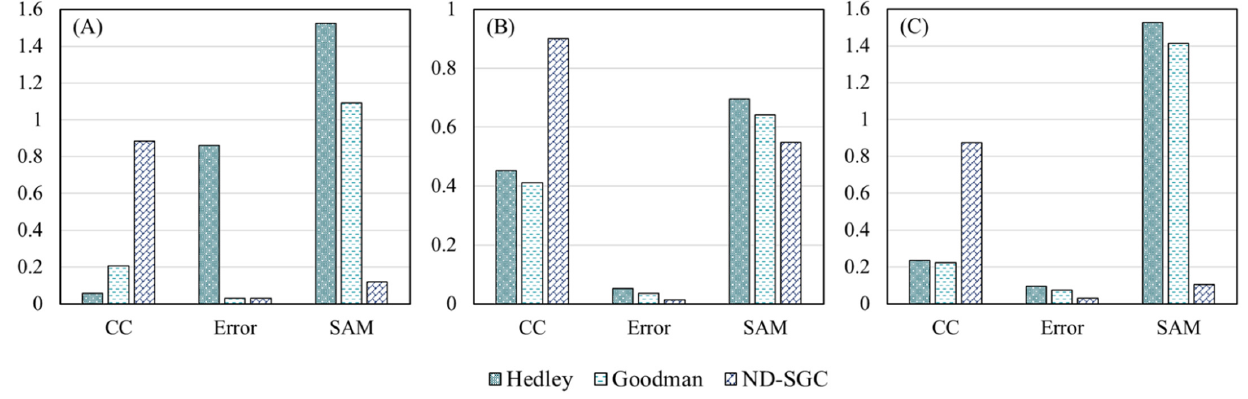
Figure 4. Spectral fidelity evaluation indexes of three sun glint correction methods for three study areas. ( A ) Dongdao Island; ( B ) Tiexian Jiao; ( C ) Taiping Island.